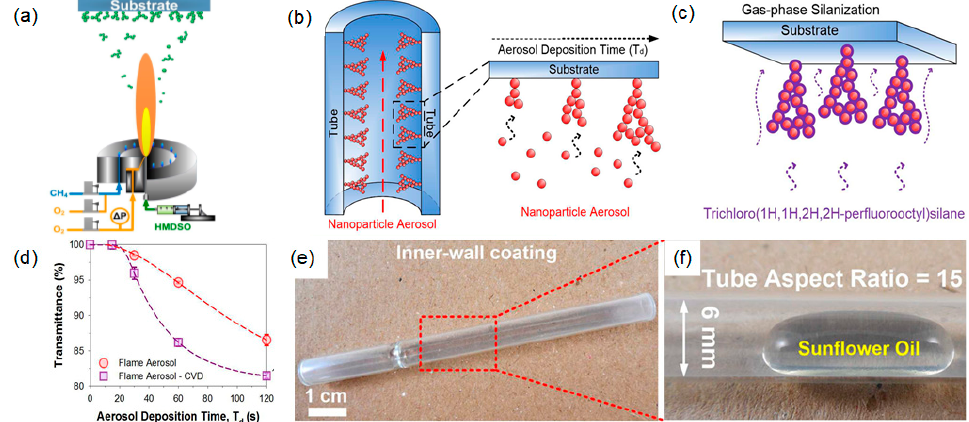
Figure 12. Self-assembly of omnidirectional re-entrant textures: ( a ) Experimental schematics of the facile two-step synthesis of superoleophobic coatings using flame aerosol; ( b ) Schematic description of the superoleophobic nano textures fabricated by omnidirectional deposition of nanoparticle aerosols; and ( c ) fluorosilanization by APCVD (atmospheric pressure chemical vapor deposition). ( d ) UV-Vis transmittance profile of superolephobic textures at 600 nm, reaching up to 99.97% at a deposition time of 15 s. Application of omnidirectional nanotexturing for ( e ) inner walls of high- aspect-ratio glass tubes with a diameter of 6 mm and length of 90 mm. ( f ) Sunflower oil droplet